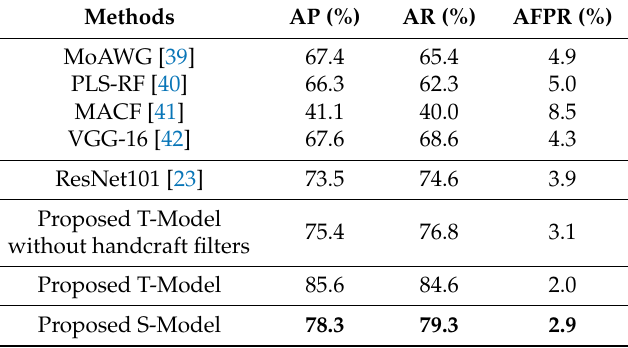
Table 1. Performance comparison results on eight methods (We referred to the results of the first three methods from the experimental evaluations in